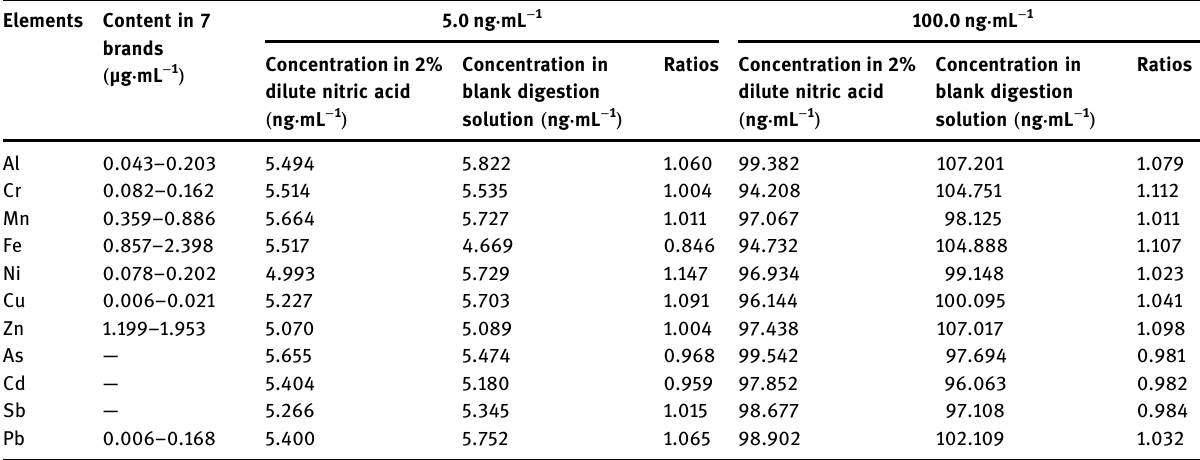
Table 6: Concentrations and ratios of 5.0 and 100.0 ng · mL − 1 mixed standard solution in two solutions Elements Content in 7